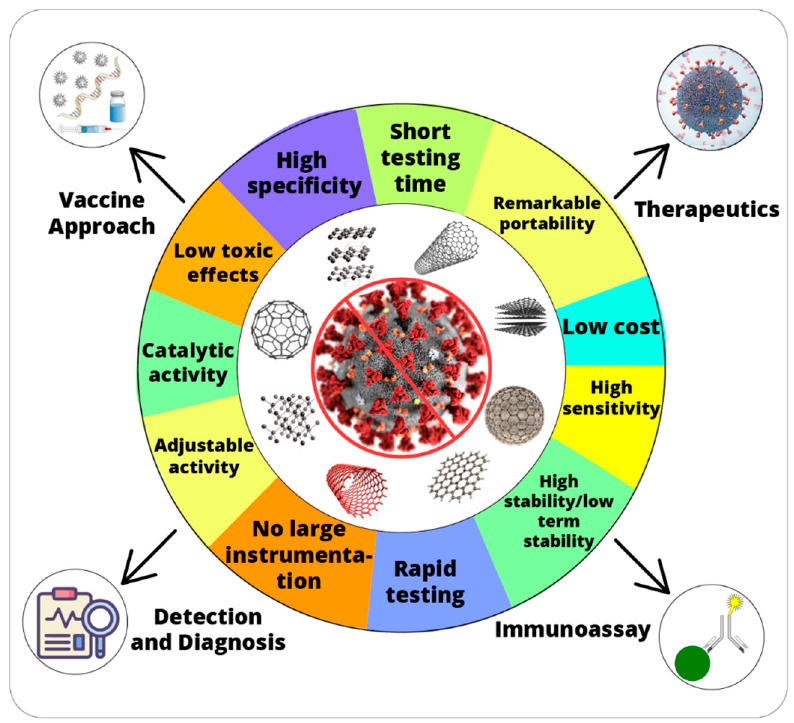
Figure 1. Advantages of nanozyme and their potential applications in fight against coronavirus disease 2019 (COVID-19). Table 2. Nanozymes used in different antiviral therapies.